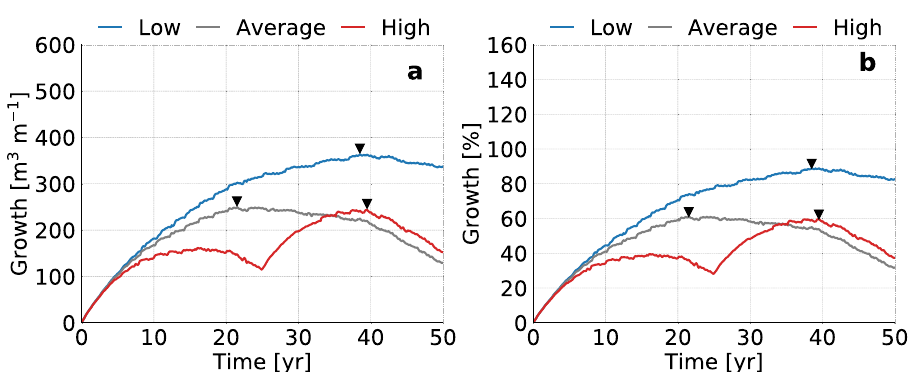
Figure 12. Simulated growth of fresh groundwater for low (blue line), average (dark grey line), and high (red line) estimates of the global coastal erosion in sandy shores, where the black triangles point to the time with the maximum growth of fresh groundwater. The graphs represent the change in volume (left) and percentage (right) with respect to the initial conditions (i.e. equal to equilibrium state without beach